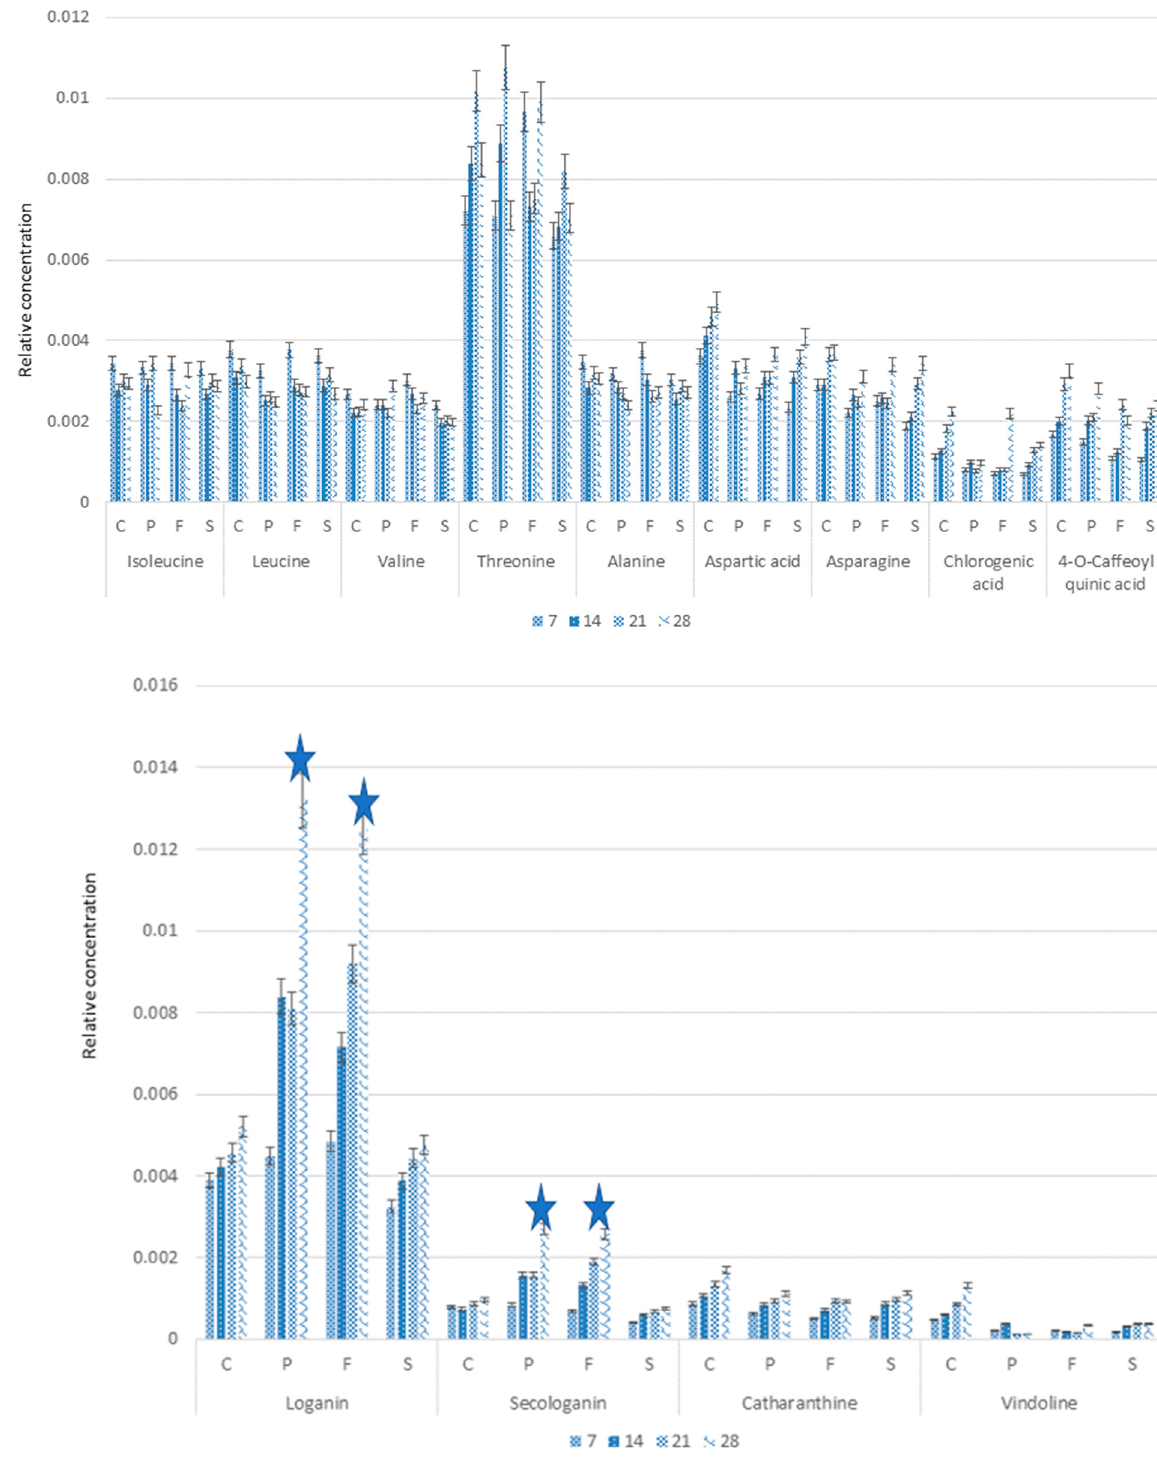
Figure 8. 1 HNMR-based quantification of metabolites in C. roseus seedlings samples after fungicides treatment in several different time points (means ± SD, n = 3). The numbers correspond to harvesting time (7, 14, 21, and 28 days after treatment) and the letters to fungicides (P—Pronto Plus, F—Folicur and S—Switch) and controlC. Data present the average and standard deviation of triplicates, * showing significance at p <